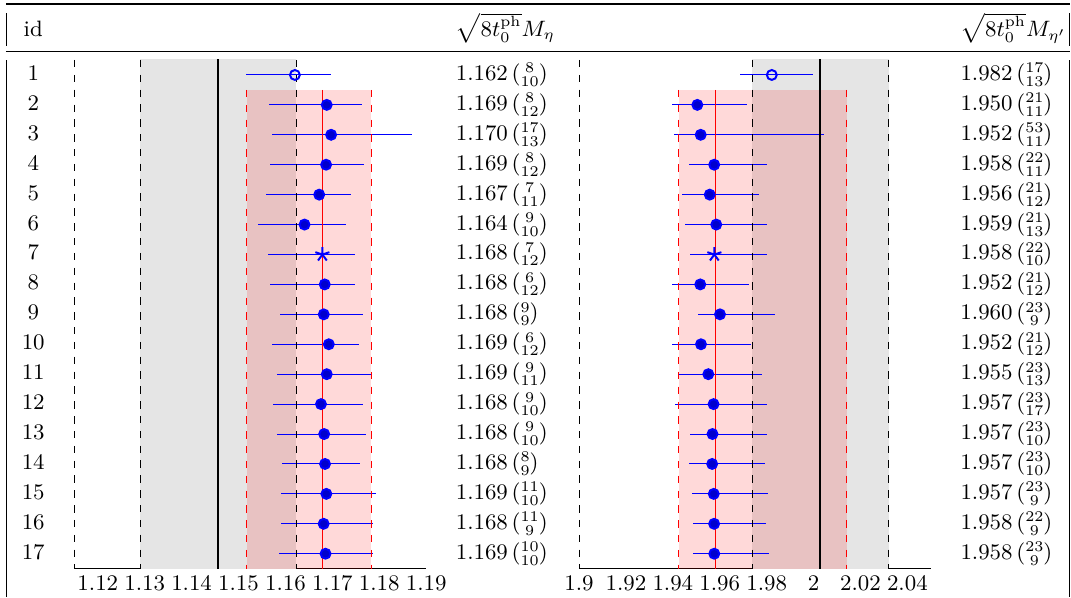
Table 10. Results for the masses of the η and η 0 at the physical point in units of the gradient flow scale. The black line marks the experimental result converted using (8 t ph and the grey shaded region marks the uncertainty due to the error on t ph central values predicted by fit 7 (see table 7). The red shaded region represents the total uncertainty of our final results where all errors are added in quadrature (see section 5.6). The first fit does not sufficiently parameterize the lattice spacing effects and is not included in the determination of the associated systematic error.